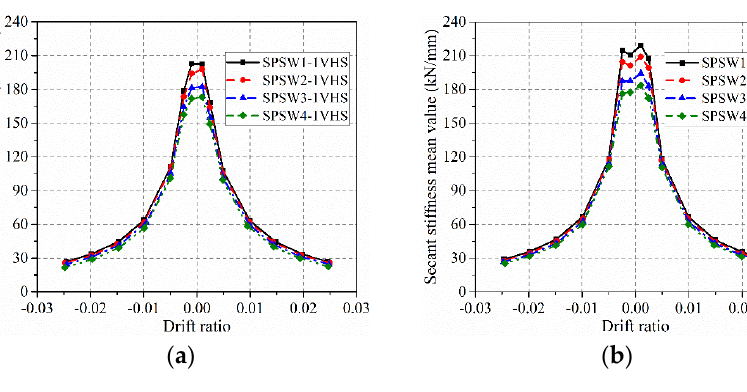
Figure 22. Secant stiffness reduction curves for: ( a ) SPSW − 1VHS, ( b ) SPSW − 3VHS, and ( c ) SPSW − DS with variable column flexural stiffnesses.